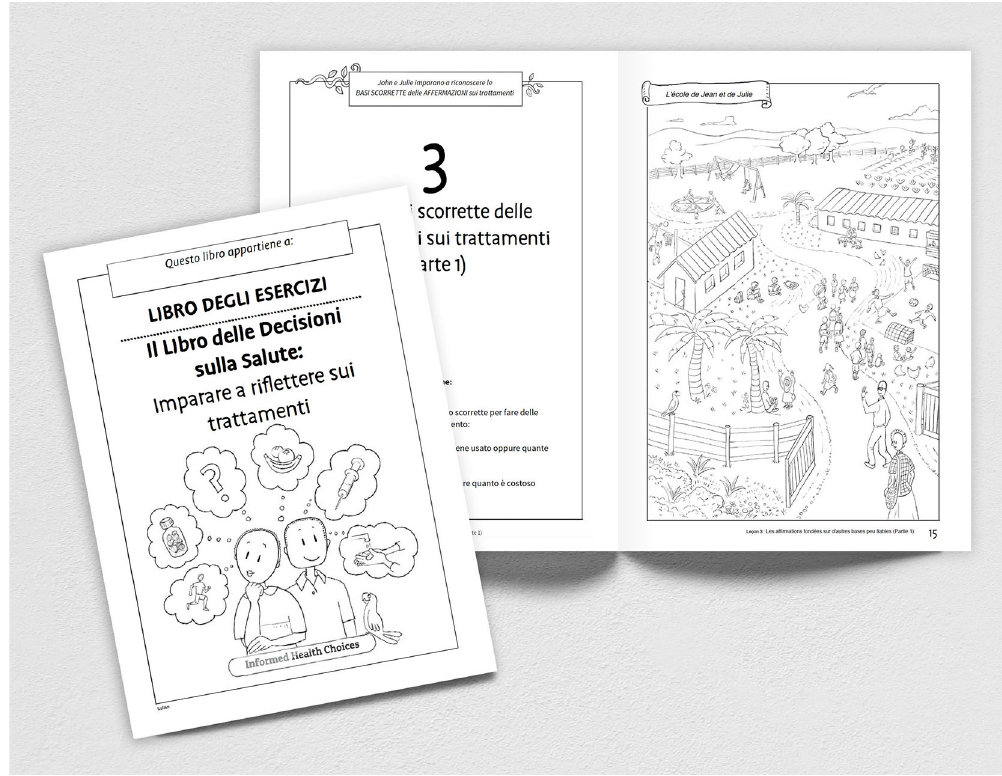
Figure 3. Italian translation of “ Exercise Book for The Health Choices Book ” , for primary school